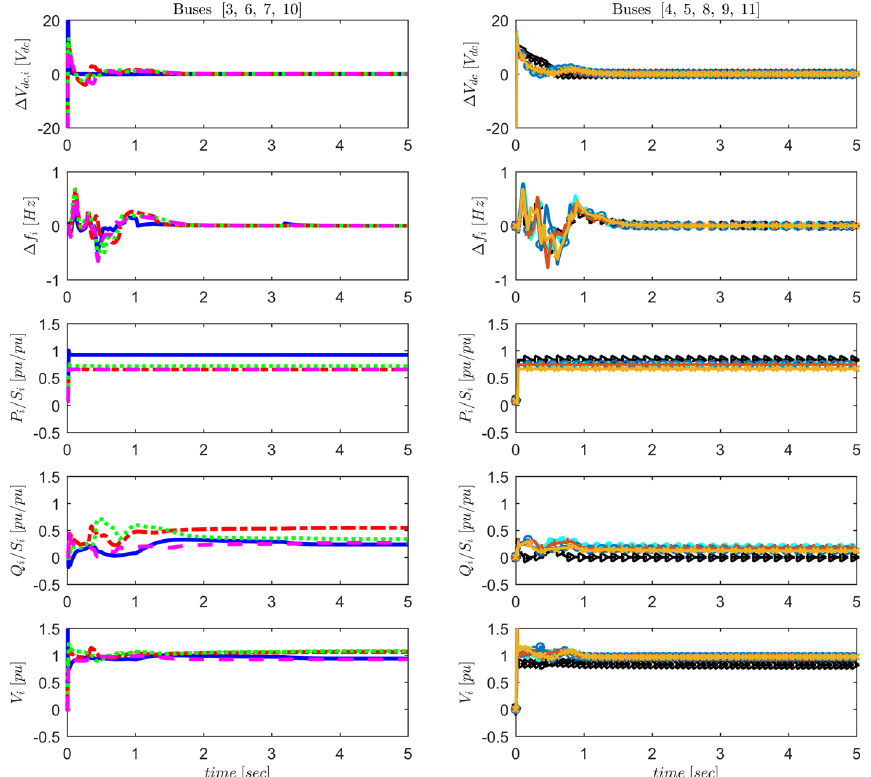
Fig. 11 Grid-connected scenario. The microsource dynamic responses including dc voltage tracking, frequency synchronization, the power sharing as well as ac voltage tracking (amplitudes at output terminals). The lines correspond to the grid-feeding microsources at: bus 3, ’–’, bus 6, ’- -’, bus 7, ’..’, bus 10, ’-.’. Moreover, the lines correspond to the other grid-feeding microsources at: bus 4, ’ > -’, bus 5, ’+-’, bus 8, ’x-’, bus 9, ’o-’, bus